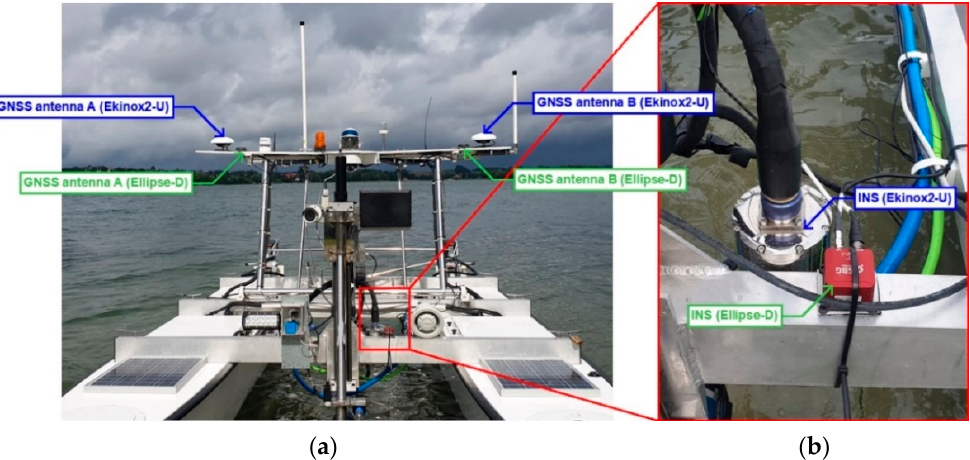
Figure 3. The arrangement of the GNSS/INS systems on the Autonomous Surface Vehicle (ASV)/USV named “HydroDron”: ( a ) view from the front of the vessel and ( b ) view on IMUs.